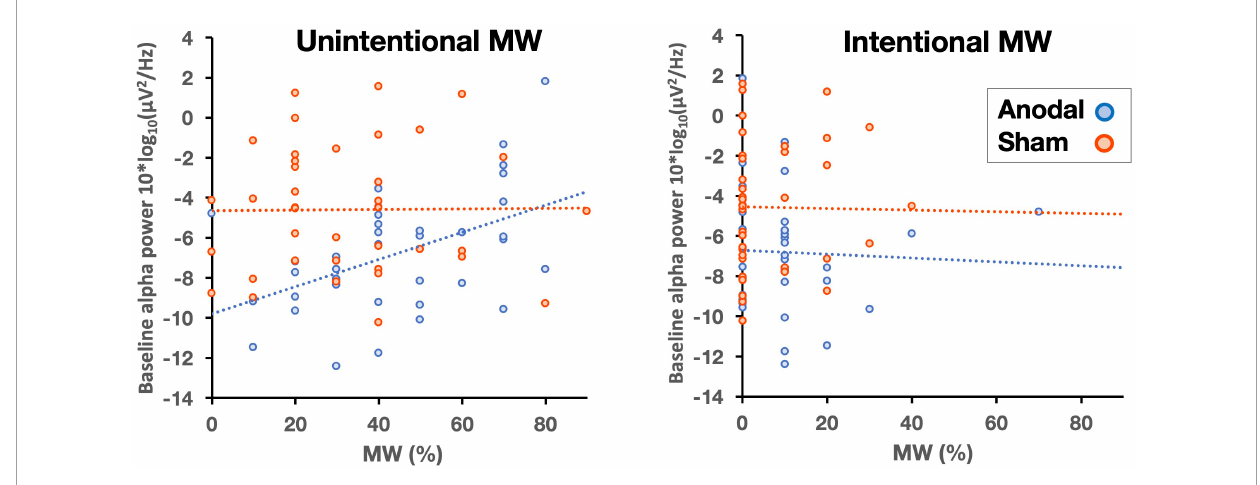
FIGURE4 Correlations between baseline alpha power and unintentional (left panel) and intentional (right panel) MW (in percentages) as a function of stimulation (anodal, sham).